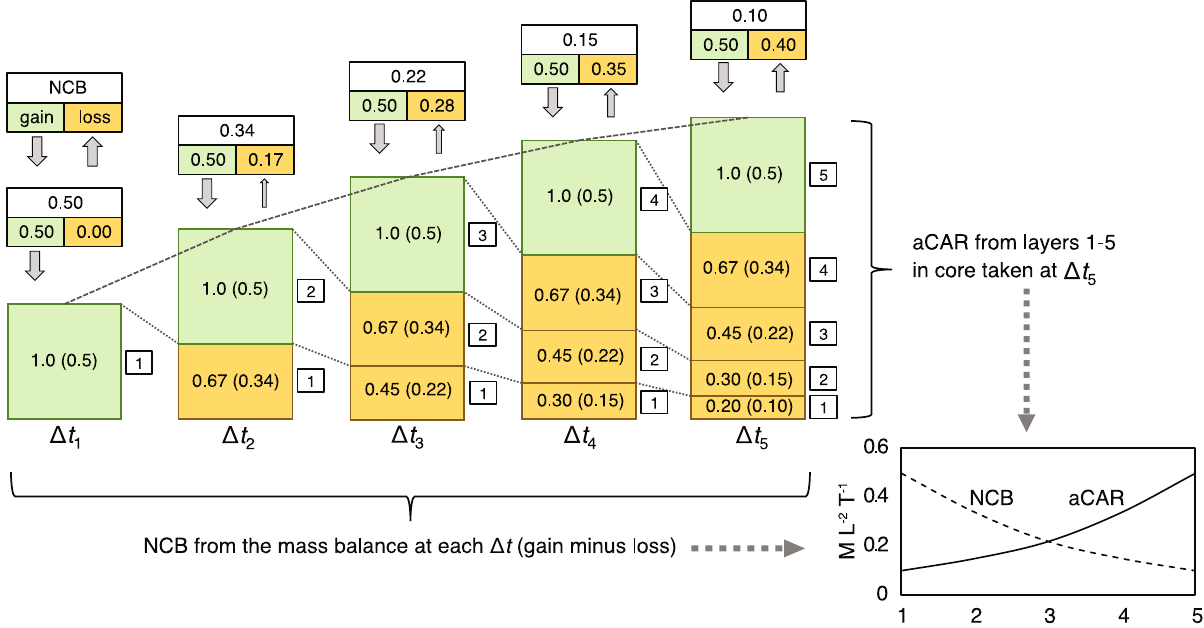
Figure 1. Scenario 1 showing the establishment phase of a peatland. Changes to a single column of peat of unit area are shown for five separate timesteps (Δ t ). Newly-added litter/peat is shown in pale green. Older peat is shown in pale brown/orange. The numbers in each layer of peat show the mass of peat and, in brackets, the mass of carbon, both per unit area (arbitrary units). NCB denotes the actual or real rate of net C accumulation and is given by the gains of C (in new litter) minus the loss of C from the decay of the older peat cohorts for each Δ t , as shown in the boxes above the columns. The arrows below the boxes represent gains (down-pointing) and losses (up-pointing) of C. aCAR is calculated for each cohort or layer at Δ t 5 . The graph shows NCB and aCAR for each Δ t . In Scenario 1, the water table always resides at the base of the peat column; there is no catotelm, and all of the peat is aerated—it is acrotelm